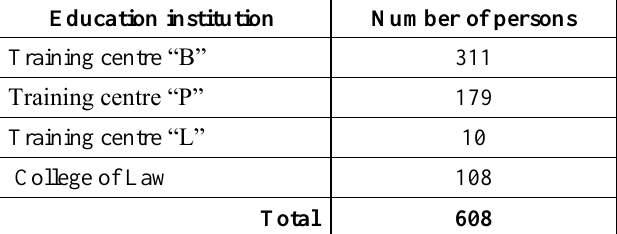
Table 2. The Number of House Managers with the 4 th Level of European Qualifications Framework and Latvian Qualifications Framework (the 3 th Level of Latvian Professional Qualification) [the authors’ calculations]